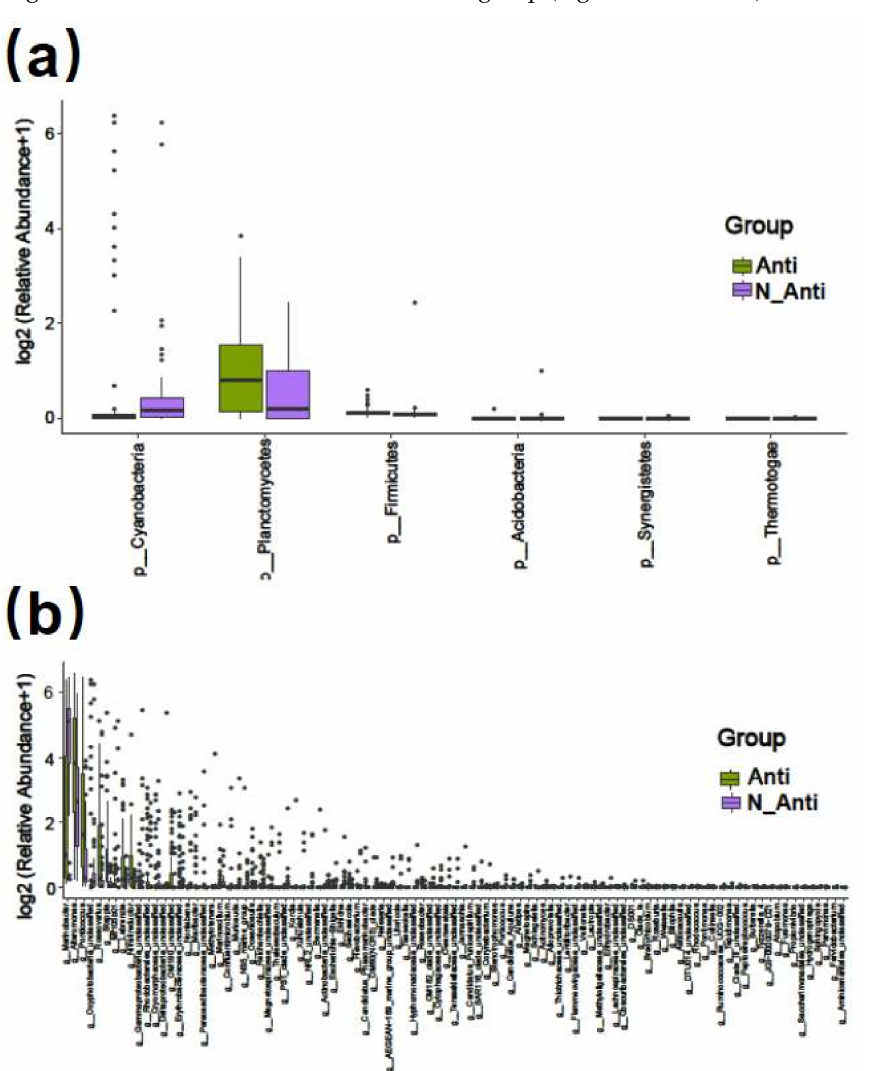
Figure 9. Bar plot of significantly different bacterial phyla ( a ) and genera ( b ) between the Anti and N-Anti